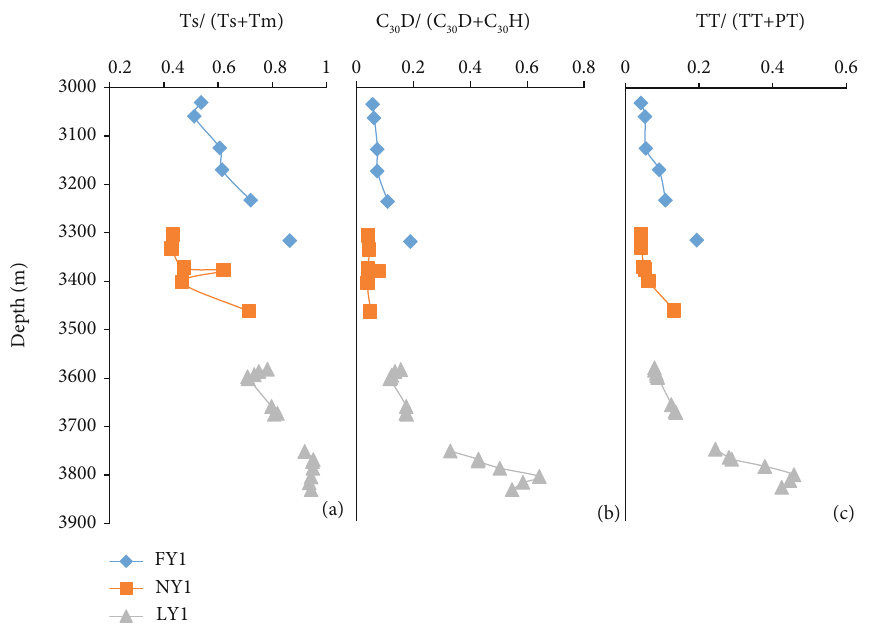
Figure 4: Maturity pro fi le derived from terpanes in the 3 studied wells. (a) Ts/ ð Ts + Tm Þ . (b) C